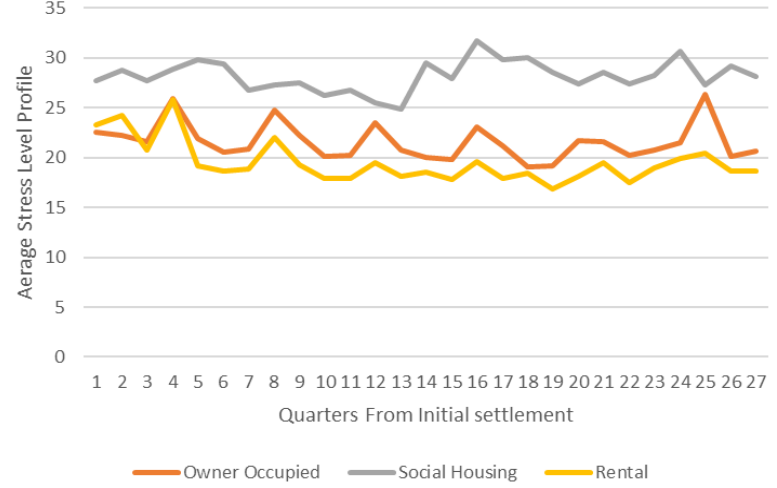
Figure 2. Average stress of non-movers by tenure, in time. Additionally, it is unsurprising that there is a jump in stress at the time of the move, which is reflected in our whole-of-population-based SRRS. Figure 3 shows the averaged stress levels of mover-individuals (homeowners and renters only) between the ages of 19 and 54 residing in urban Auckland between 2013 and 2018, the first move after two years of stay and by frequency of moves within five years. The jump is higher than the stress score assigned to the change in residence (20 points), which indicates other stressors were present at the time of the move. However, what is pertinent is that the average baseline stress after the move event increases with the number/frequency of moves over the 5-year period (i.e., 3-moves > 2-moves > 1-moves). This supports our hypothesis 2 that ceteris paribus , a more frequent change in residence, will increase the overall stress level of individuals. Furthermore, the average stress after a moving event is higher than before.